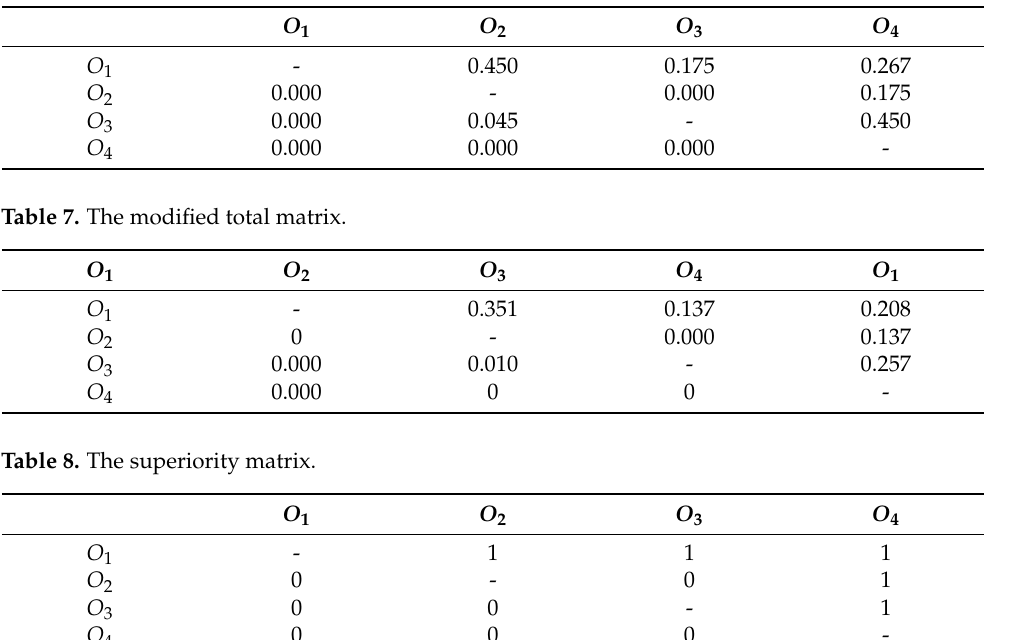
Table 6. Modified discordance matrix.